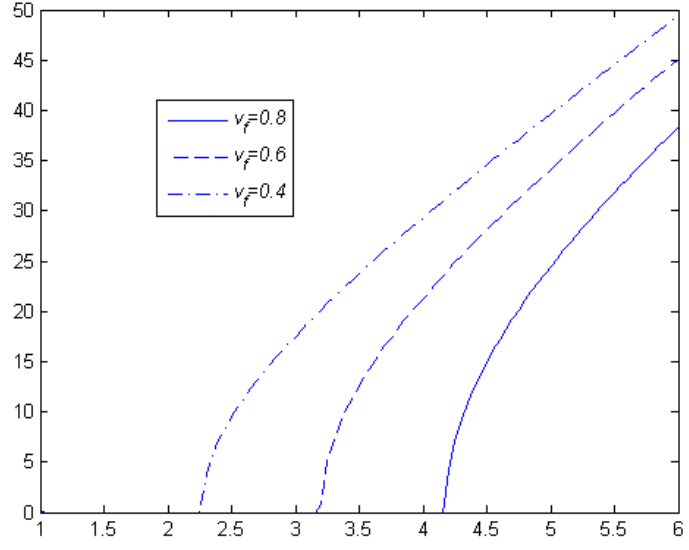
Figure 5. The first supercritical natural frequencies for a fixed–fixed case.